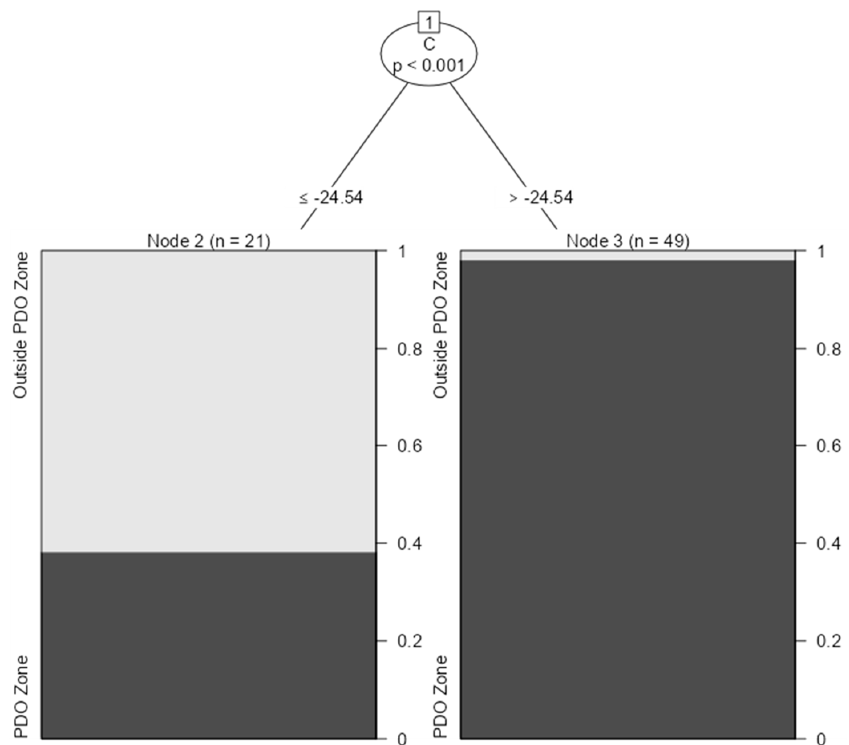
Figure 3. Decision tree analysis to discriminate currant samples coming from the PDO zone of “Vos- tizza” against samples outside of this